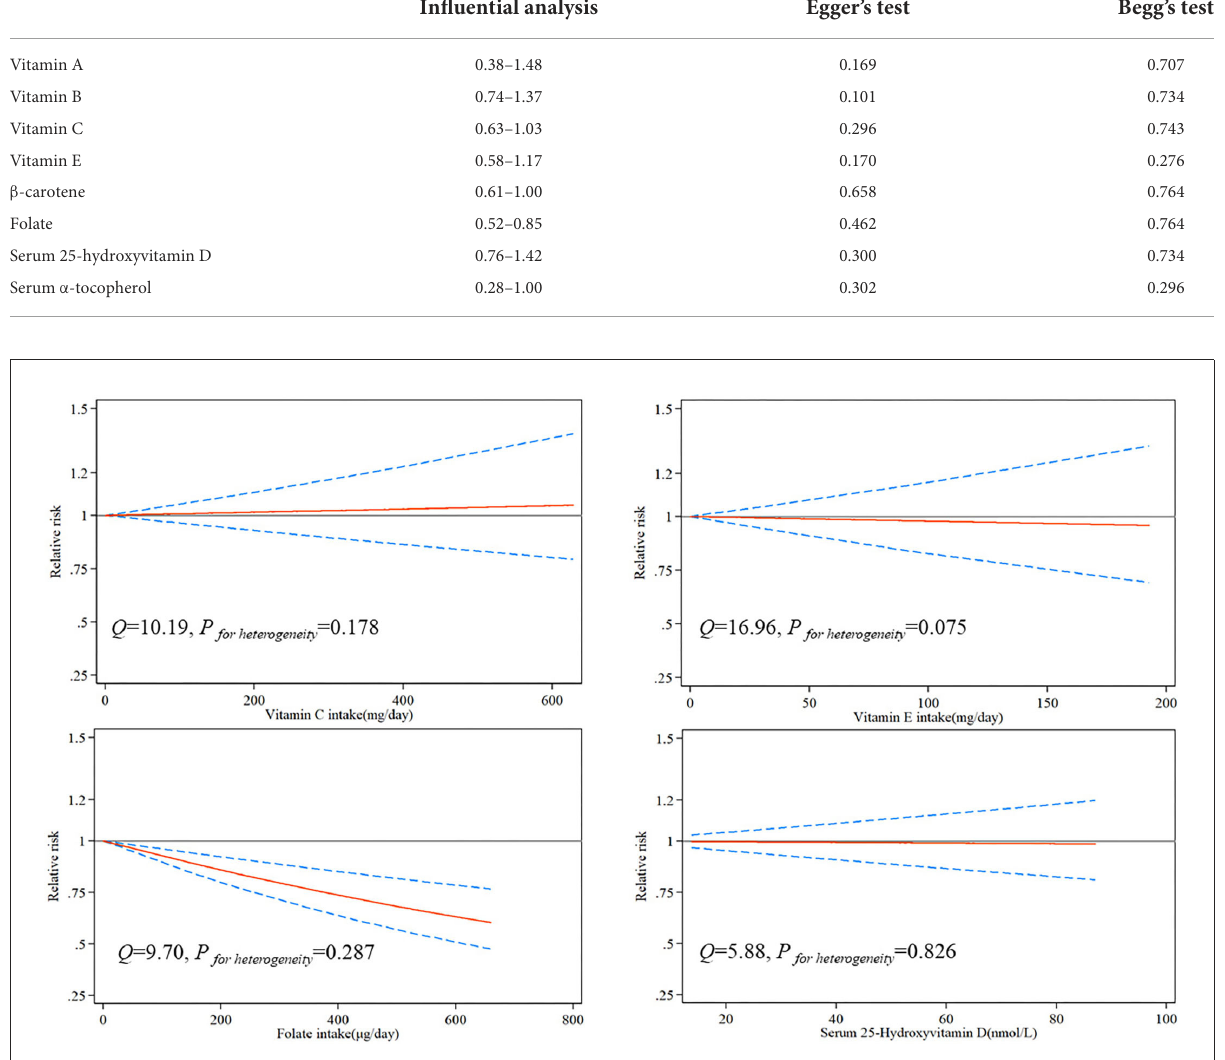
FIGURE2 Risk between vitamins and brain tumors estimates from dose-response